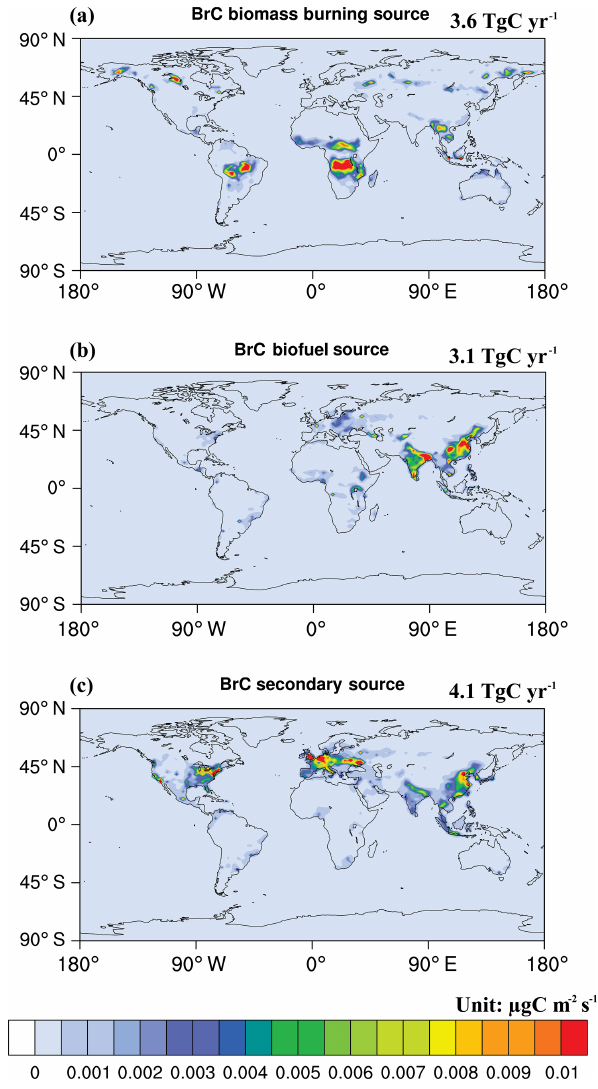
Figure 1. Spatial distributions of global emissions of BrC from biomass burning (a) , anthropogenic biofuel combustion (b) and sec- ondary formation (c) in 2010. The unit is µgCm − 2 s − 1 . The total emission is 3.6, 3.1 and 4.1TgCyr − 1 for biomass burning, biofuel and secondary formation, respectively.